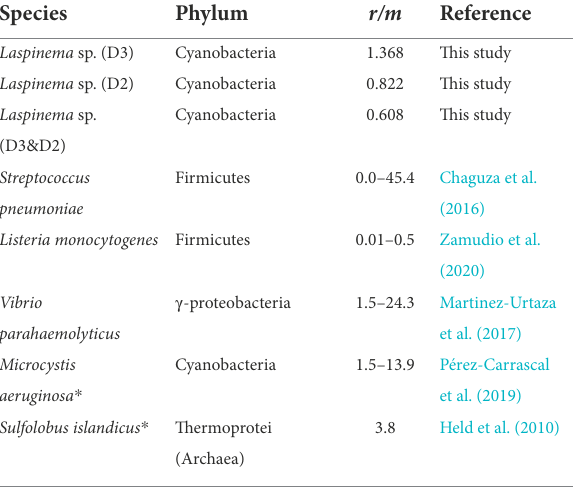
TABLE 2 The relative effect of recombination and mutation ( r / m ) for different microbial species based on whole genomes or multilocus sequence analysis from previous